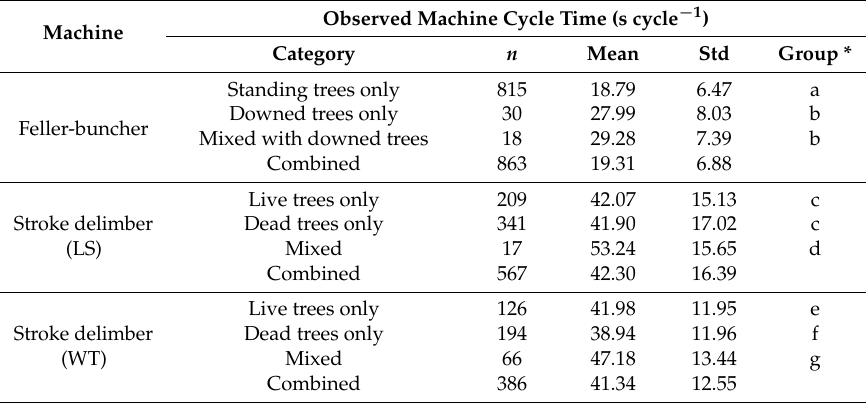
Table 5. Observed machine cycle times of feller-buncher and stroke delimber based on the tree conditions in beetle-kill salvage harvesting (LS: lop and scatter; WT: whole-tree